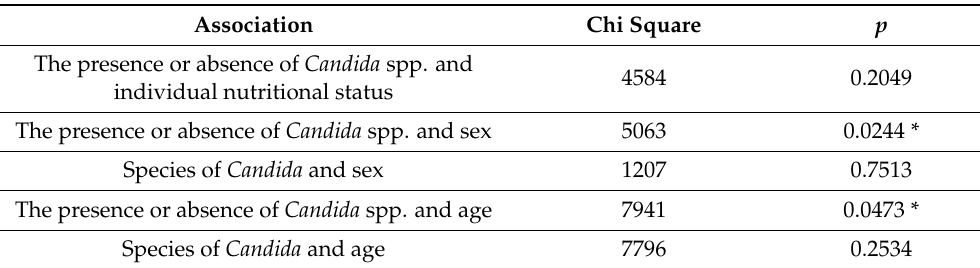
Figure 1. Phenotypic identification of Candida isolates in CHROMagar Candida. ( A ) Candida albicans (green), Candida krusei (pale pink), Candida glabrata (purple). ( B ) Candida albicans (green). ( C ) Candida albicans (green), Candida glabrata (purple). Table 1. Comparison between the studied variables.